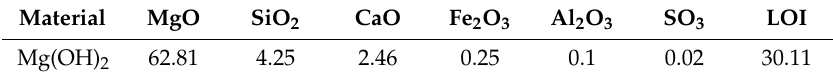
Table 1. Mg(OH) 2 powder composition (%) used for the coatings’